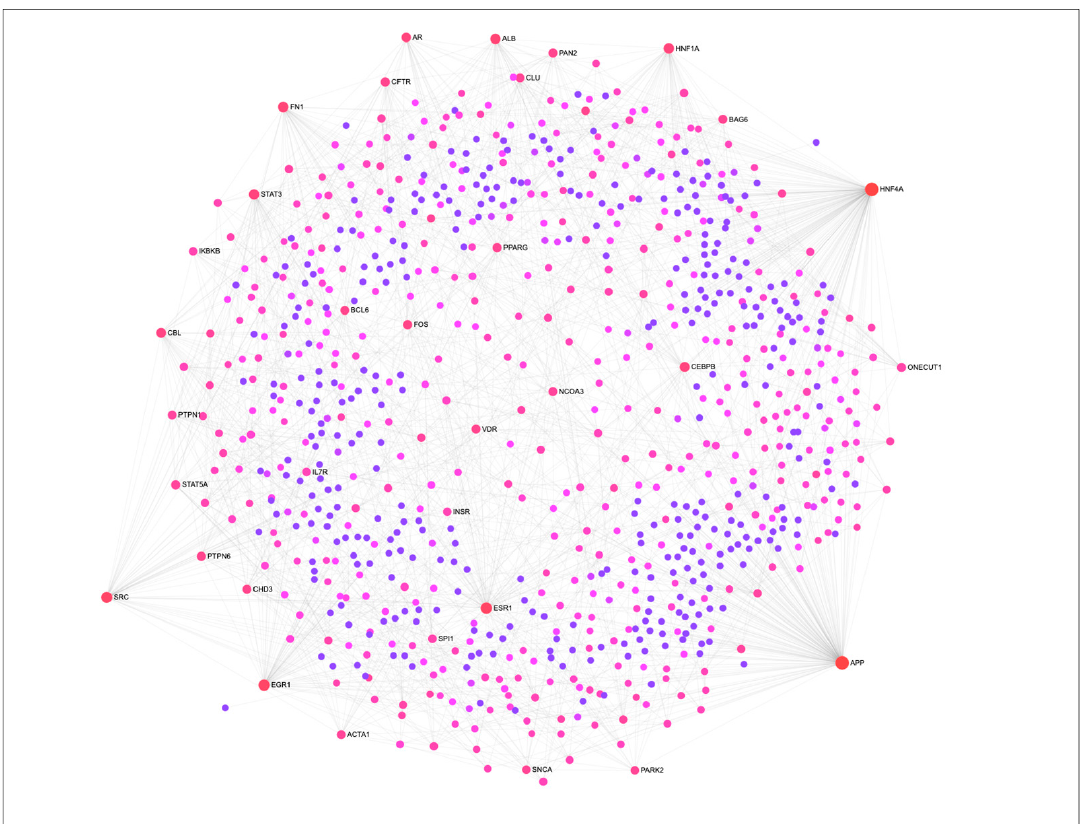
Figure 1. The protein-protein interaction (PPI) network of DEGs associated with adipogenesis in porcine intramuscular adipocyte. The PPI network was constructed by using NetworkAnalyst software incorporated with InnateDB interactome database. Circular nodes represent the differentially expressed genes, and edge represent the interaction. Circle diameter represents the degree centrality (number of connections it has to others), while the color intensity (from purple towards red) of a node represents the betweenness centrality (number of connections passing through this node) of the network. (Figure 2). The top ten significantly enriched KEGG pathways includes ‘PPAR signaling’, ‘Complement and coagulation cascades’, ‘Neuroactive ligand-receptor interaction’, ‘Insulin resistance’, ‘PI3K-Akt signaling’, ‘cGMP-PKG signaling’, ‘Thyroid hormone synthesis’, ‘Pancreatic secretion’, and ‘Fat digestion and absorption’ pathways (Figure